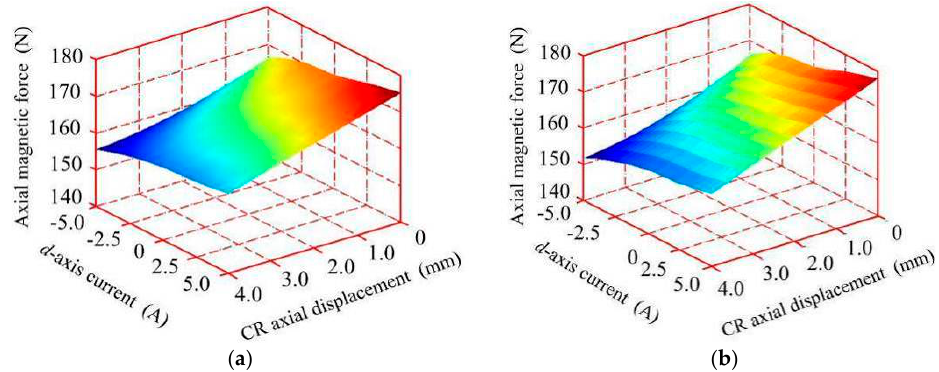
Figure 21. The axial magnetic force result under various d -axial currents and CR axial displacement: ( a ) 3-D FEM, ( b ) Measured.